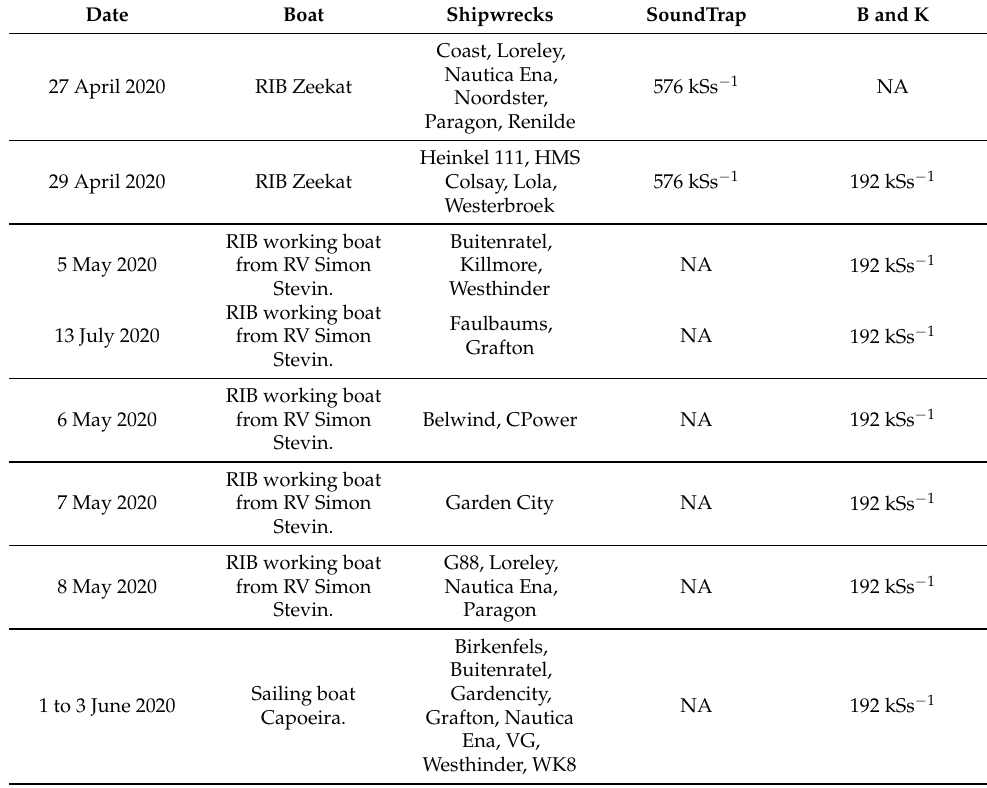
Table A1. Summary of all the field work days and the equipment